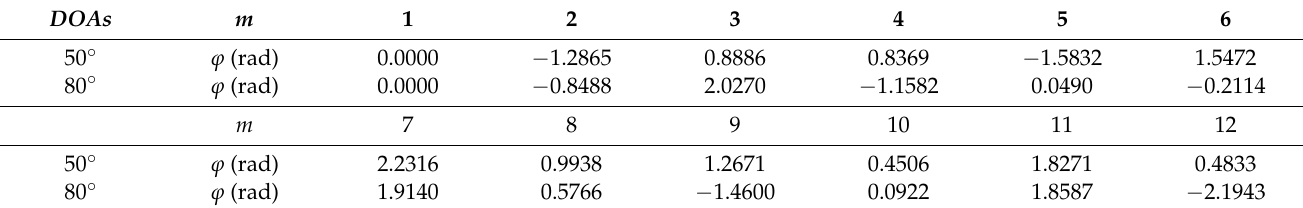
Table 2. Sensor phase